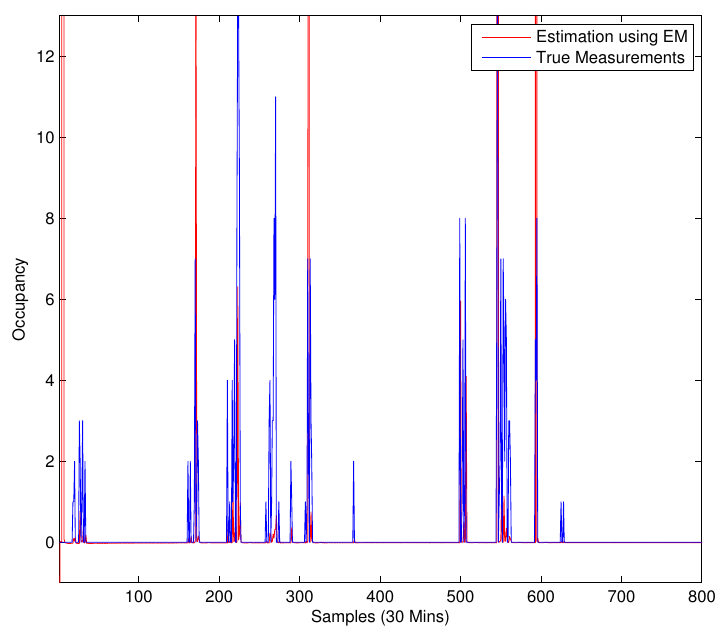
Figure 6. Occupancy estimation using EM algorithm.